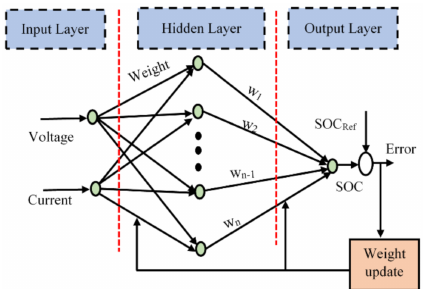
Figure 2. Structural design of the proposed backpropagation neural network (BPNN)